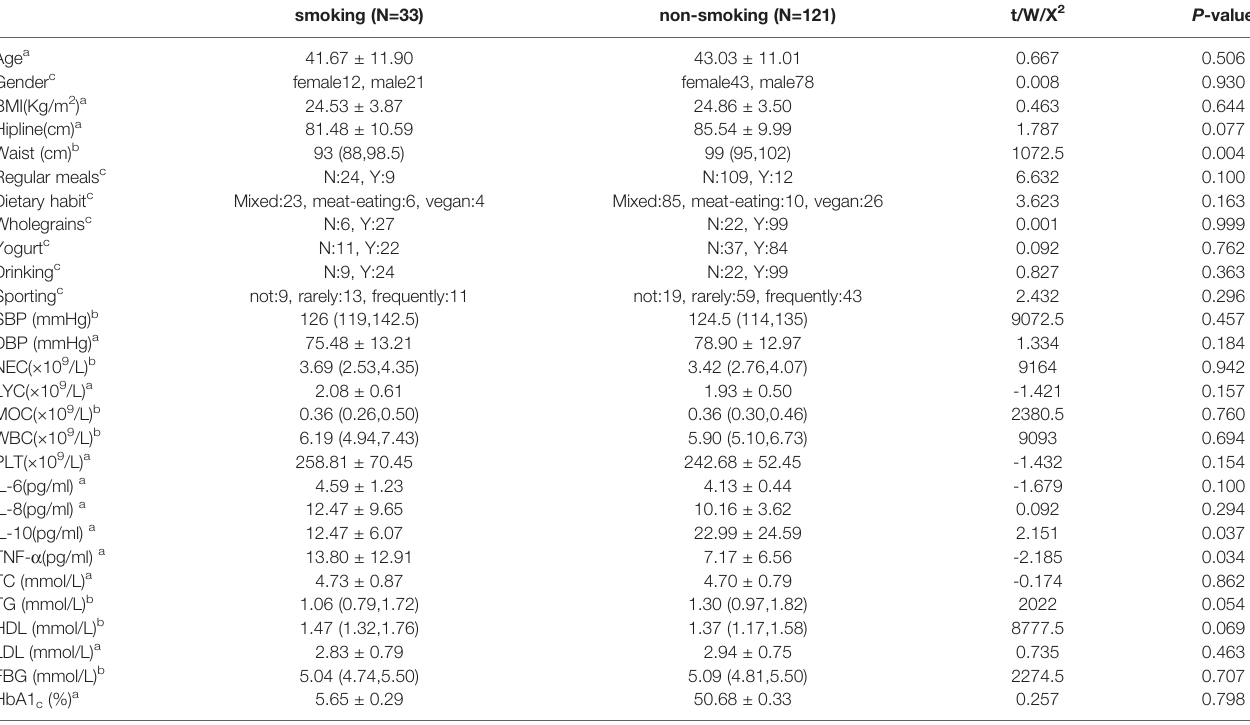
TABLE 1 | Participants ’ demographic and serum